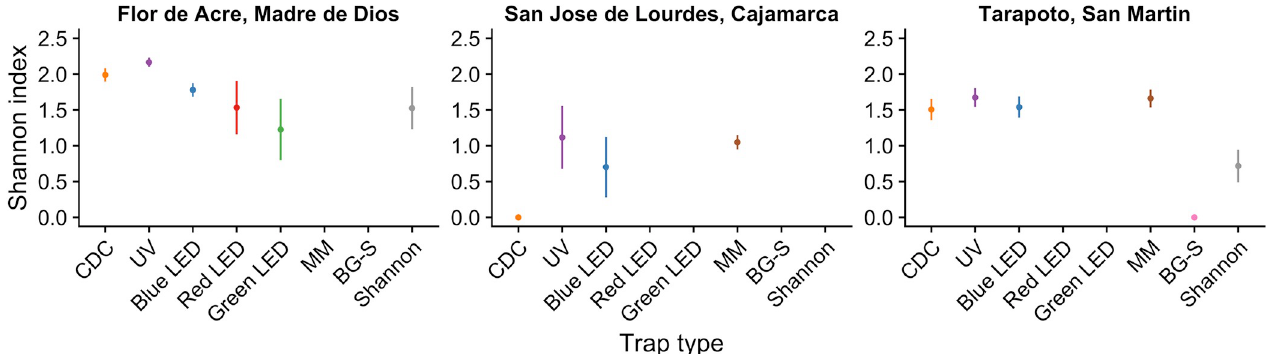
Fig 4. Comparison of sand fly Shannon diversity indices across trap types and study sites. The figure shows the Shannon diversity index (and estimated confidence intervals) for the different traps employed in collections. No panel was included for Caraz, Ancash because there were only two sand fly species trapped (S2